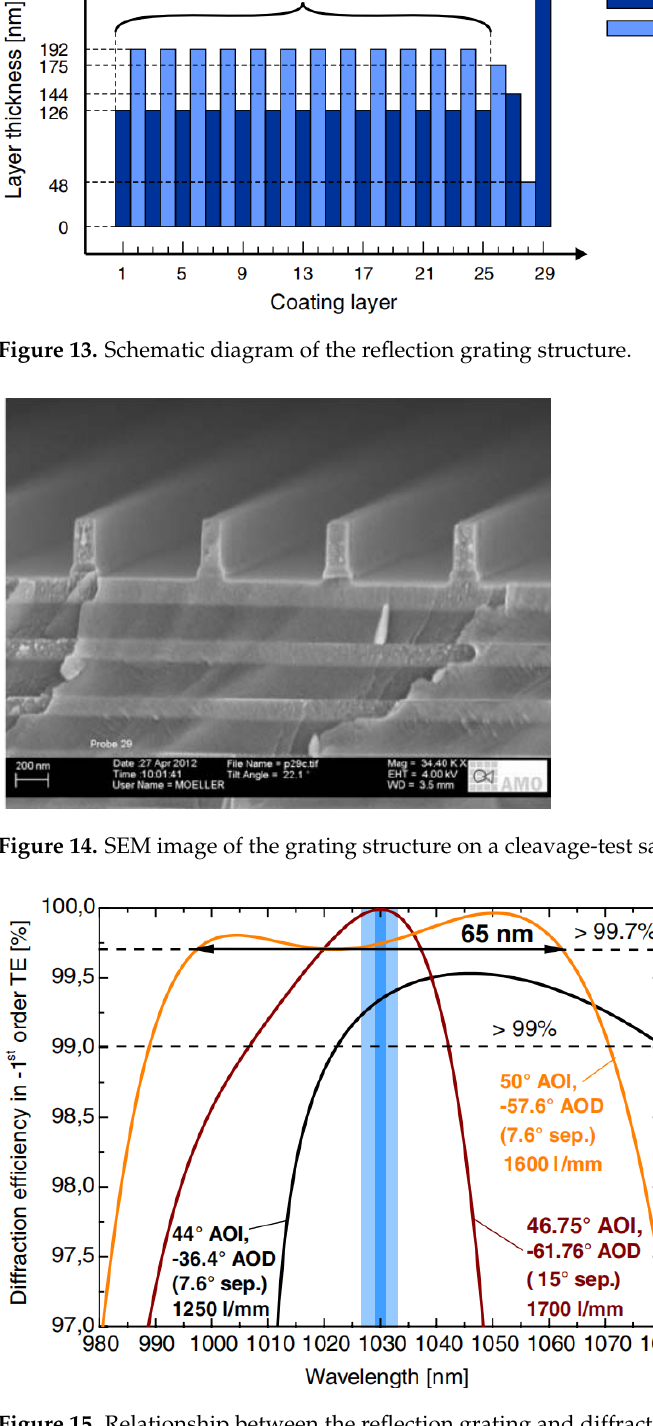
Figure 15. Relationship between the reflection grating and diffraction efficiency.